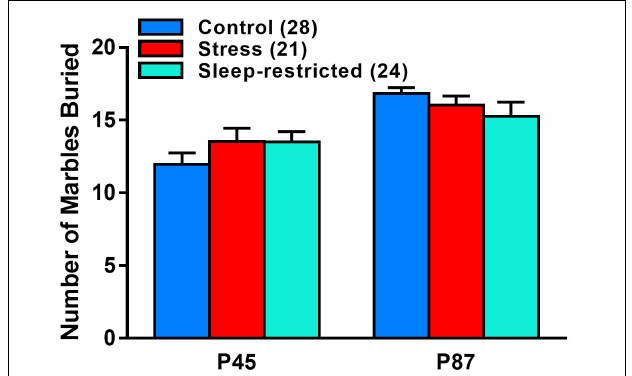
FIGURE 6 | Effects of stress and sleep-restriction on repetitive behavior at P45 and P87. Results of ANOVA are given in Table 2 . The age × condition interaction approached statistical significance ( p = 0.065) suggesting that control and stress groups buried more marbles at P87 than at P45, but this behavior was not increased in the older sleep-restricted mice. Each bar is the mean ± SEM for the number of mice indicated in parentheses.